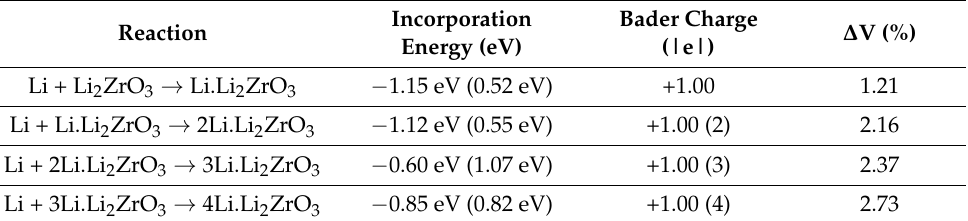
Figure 7. Relaxed structures of ( a ) a single Li, ( b ) 2Li, ( c ) 3Li and ( d ) 4Li incorporated in LZO. Table 5. Calculated energies to incorporate Li atoms into LZO, Bader charges on the Li atoms and volume expansion upon successive